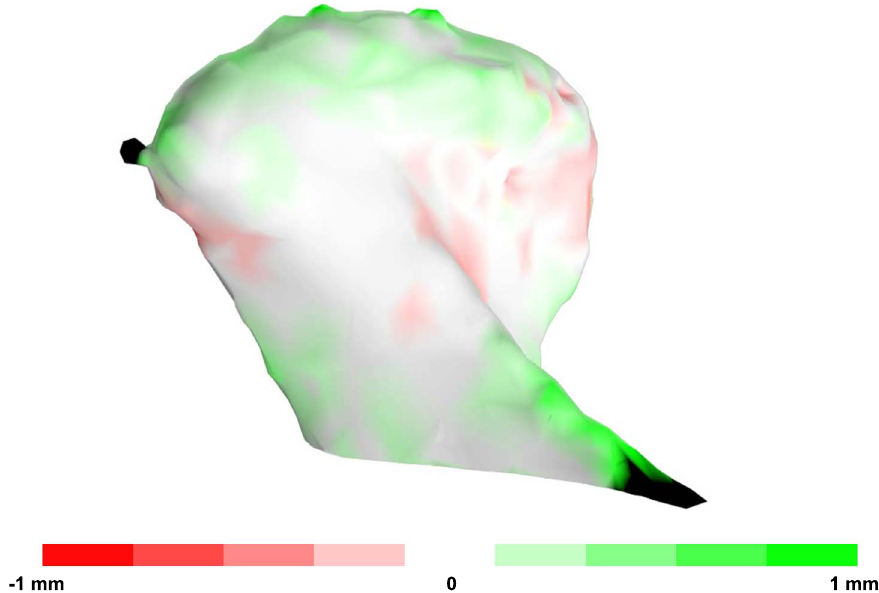
Figure 3. A typical 3D distance map of the manually and semi-automatically segmented condyles. The green area indicates the surface of the manually segmented condyle whereas the red area indicates the surface of semi-automatically segmented condyle. The colour intensity quantifies the distance between both surfaces. Only small differences are present between both surfaces.